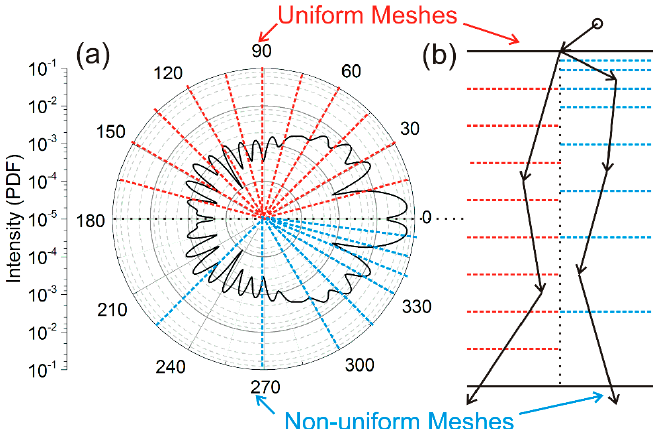
Figure 1. Schematic of uniform and non-uniform discretization. Panel ( a ). Angular discretization. Panel ( b ). Thickness discretization.